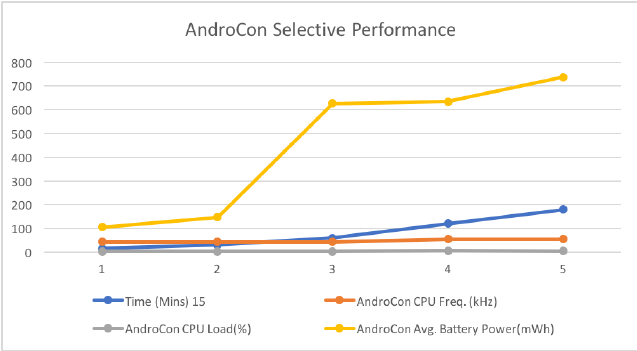
Figure 7. AndroCon CPU Utilizationand battery